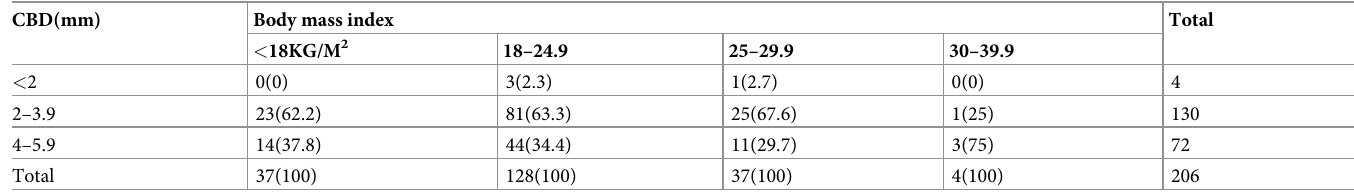
Table 3. Diameter of CBD stratified by body mass index, Northwest Ethiopia, 2019.